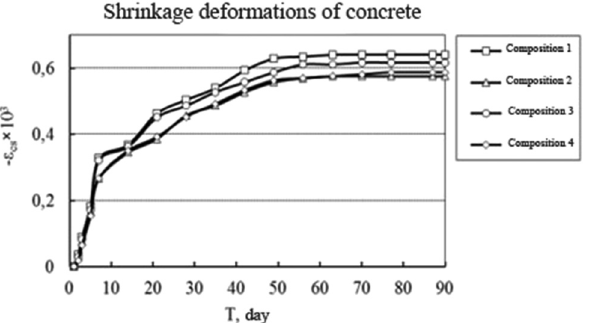
Figure 17: Kinetics of concrete